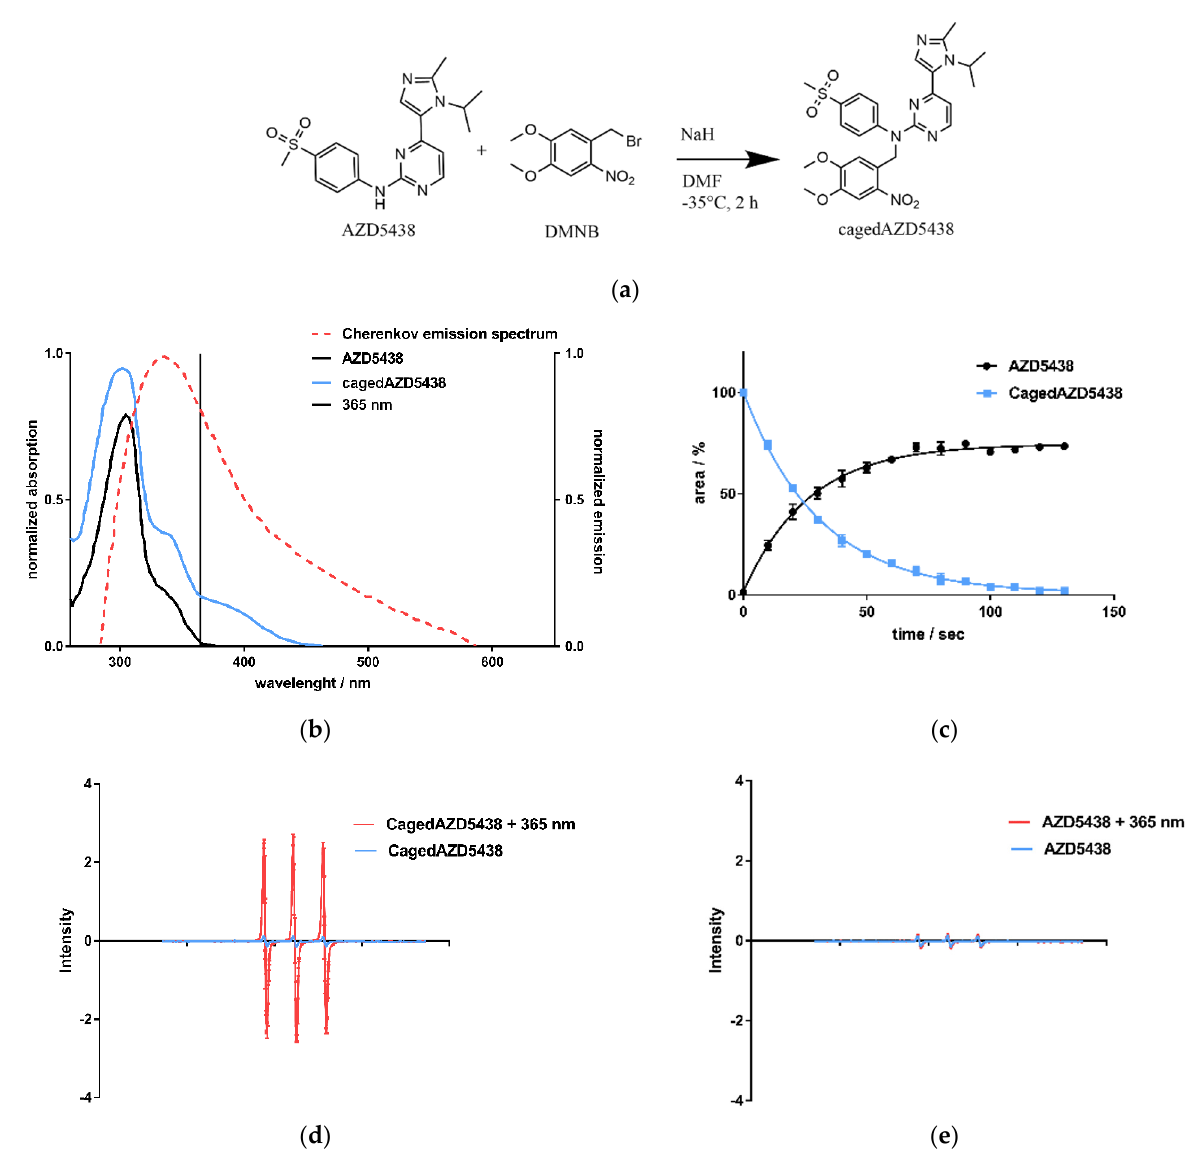
Figure 3. ( a ) CagedAZD5438 was synthesized according to the general procedure for caging of N -phenylpyrimidin-2-amines with benzyl bromides [59]. In an S N 2 reaction, benzyl bromide in dry DMF is added dropwise to AZD5438 at − 35 ◦ C under argon atmosphere (yield 55.6%, further details in SI). ( b ) UV/Vis spectra of AZD5438 and cagedAZD5438 with DMNB in aqueous medium with 20% DMSO as solubilizer. An overlay of the Cherenkov emission spectrum (dotted line) illustrates the potential usage for photoactivation, indicating 365 nm as a suitable wavelength for control experiments. Other UV/Vis spectra with different solutions are shown in the SI, Figure S7. ( c ) Photoactivation of cagedAZD5438 by irradiation with UV light at 365 nm; an aqueous compound solution containing 50 µ M prodrug cagedAZD5438 (blue line) and 20% DMSO was irradiated at 365 nm, 37.5 mW, every 10 s and then analyzed by HPLC. Repeated experiments with the free inhibitor AZD5438 (Figure S9d) as a control were carried out. Each value is the mean ± SD of four independent experiments. ( d ) Electron spin resonance (ESR) spectra of the spin probe TMTH (1-hydroxy-4-isobutyramido-2,2,6,6- tetramethylpiperidine) incubated with cagedAZD5438 in DMSO without and with irradiation (365 nm, 100 s, 37.5 mW per well). ( e ) ESR spectra of a solution of AZD5438 with and without irradiation (365 nm, 100 s, 37.5 mW per well). As a positive control, the photosensitizer 1,4-naphthoquinone [63] in DMSO was tested under the same conditions. The sample solutions contained the spin probe TMTH (2.5 mM) and 50 µ M cagedAZD5438 in 20% DMSO. Error bars indicate SD with N = 3. We achieved the synthesis of cagedAZD5438 by the established general procedure for caging of N -phenylpyrimidin-2-amines with benzyl bromides under argon atmosphere